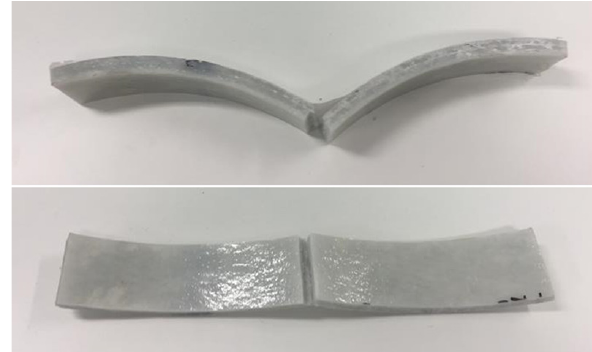
Figure 14: Example of a damaged sample.